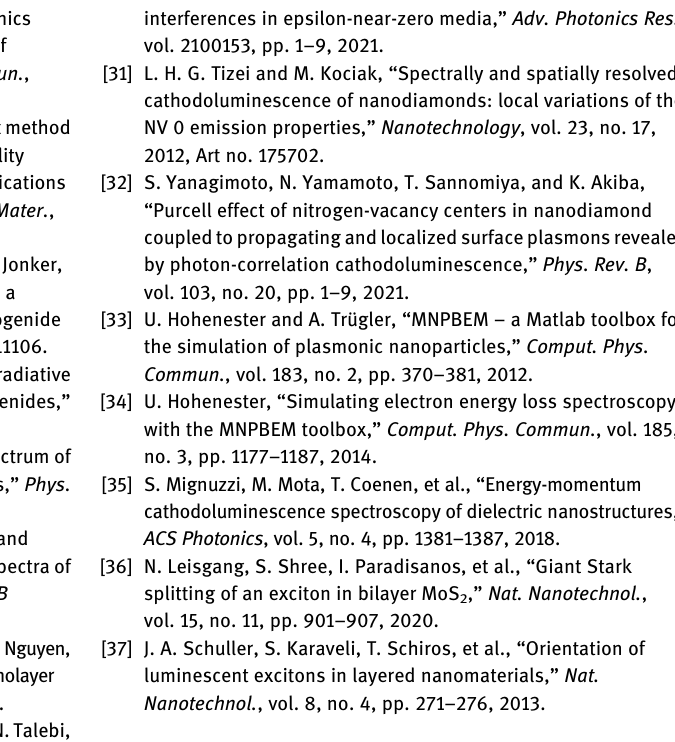
Supplementary Material: Effect of particle dimensions on CL spectra, and comparison of experimental and simulated CL spectra for nano- flakes of various sizes. The online version of this article offers sup- plementary material